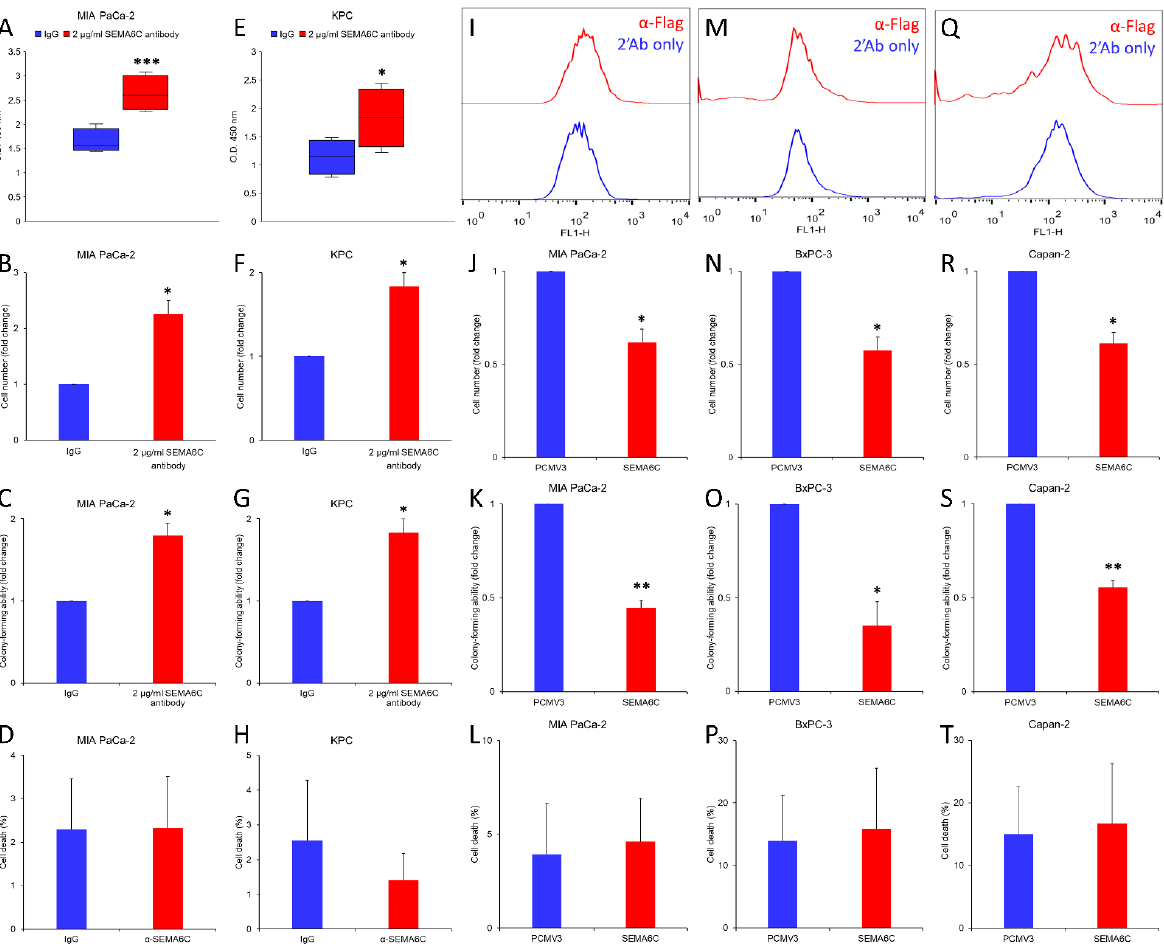
Figure 3 . SEMA6C influences pancreatic cancer proliferation. Human pancreatic cancer cell lines